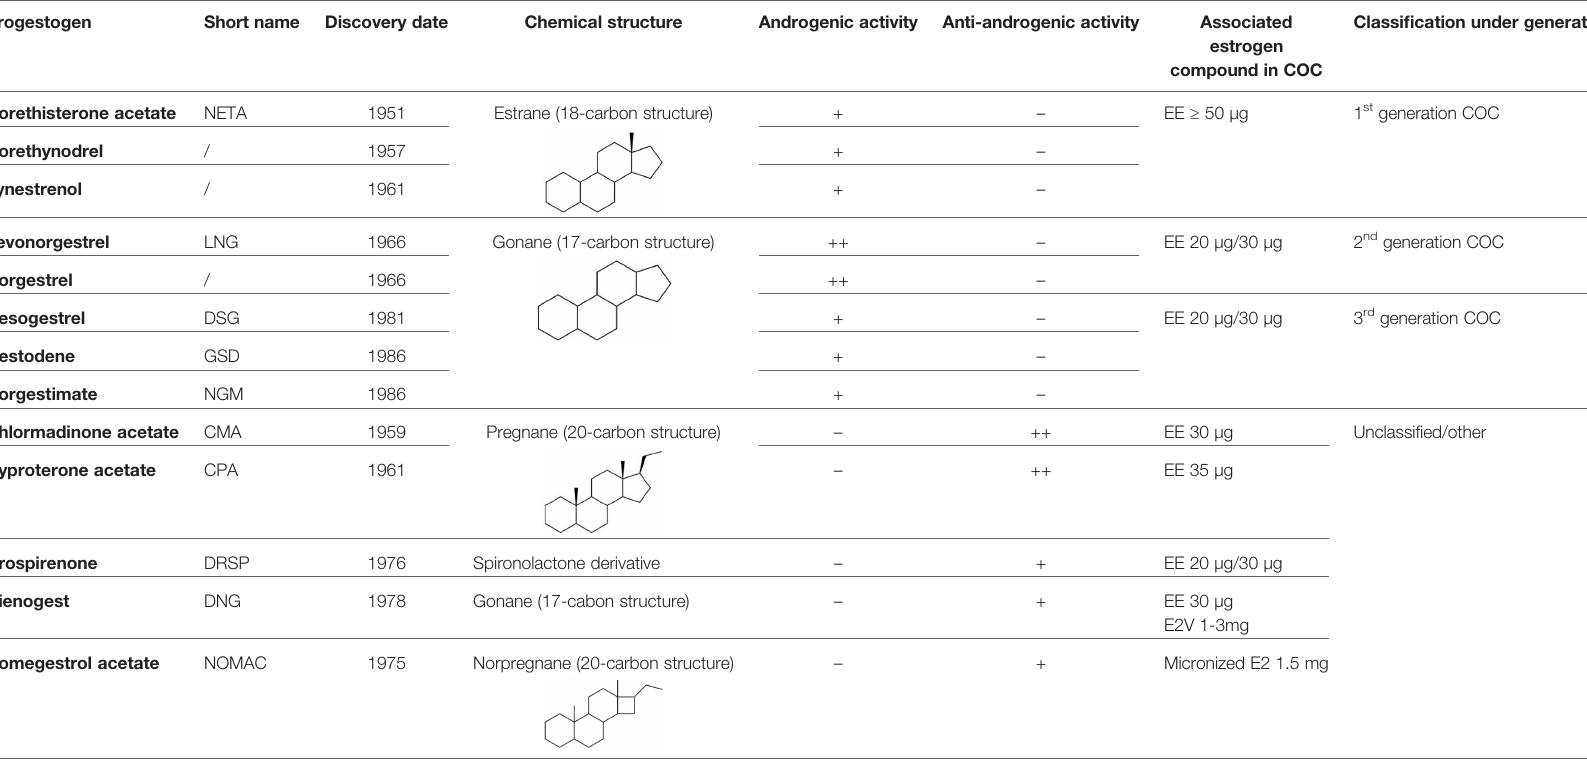
TABLE 1 | Progestogens - Discovery, chemical structure, androgenic activity, associated estrogen compound in combined oral contraceptives (COC) and classi fi cation under generation.